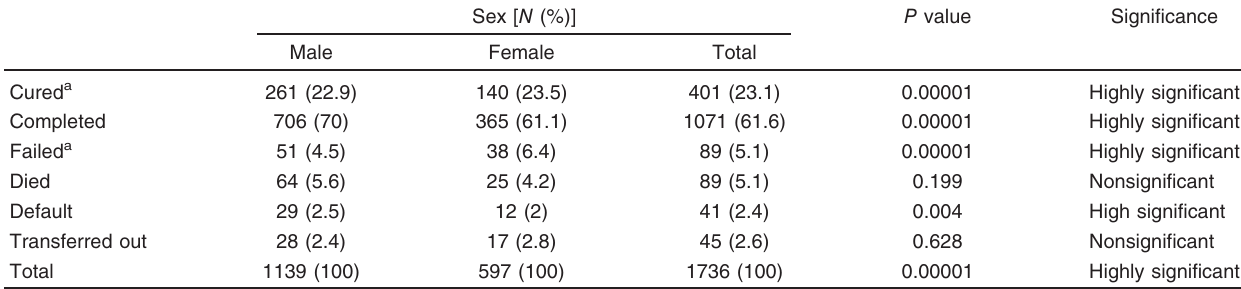
Table 8 Distribution of total tuberculous cases according to the sex and statistical analysis between male and female (2006 – 2011) Sex [ N (%)] P value